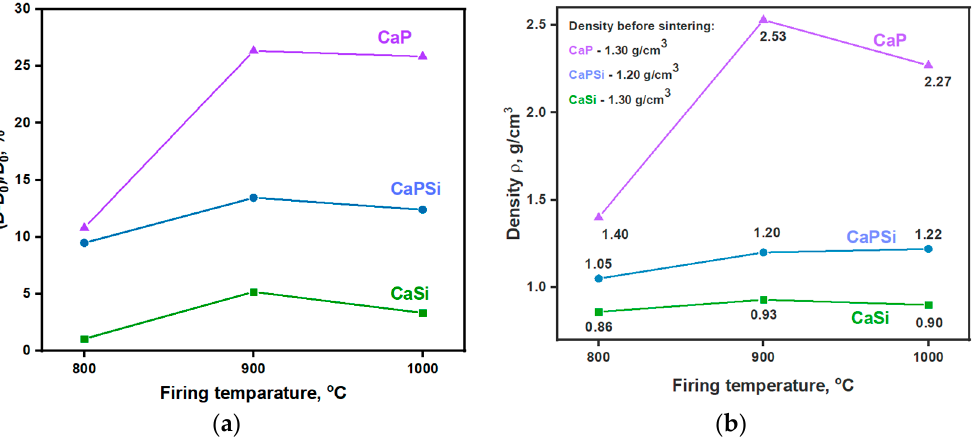
Figure 6. ( a ) Shrinkage during heat treatment, and ( b ) density of samples CaP, CaSi, and CaSi. The CaP sample had the largest linear shrinkage (up to 26% at 900 and 1000 °C), and the CaSi sample had the smallest linear shrinkage (up to 5%) (Figure 6a). Linear shrinkage for the CaPSi sample ranged from 9 to 13% at 800 to 1000 ° C, respectively. At the same